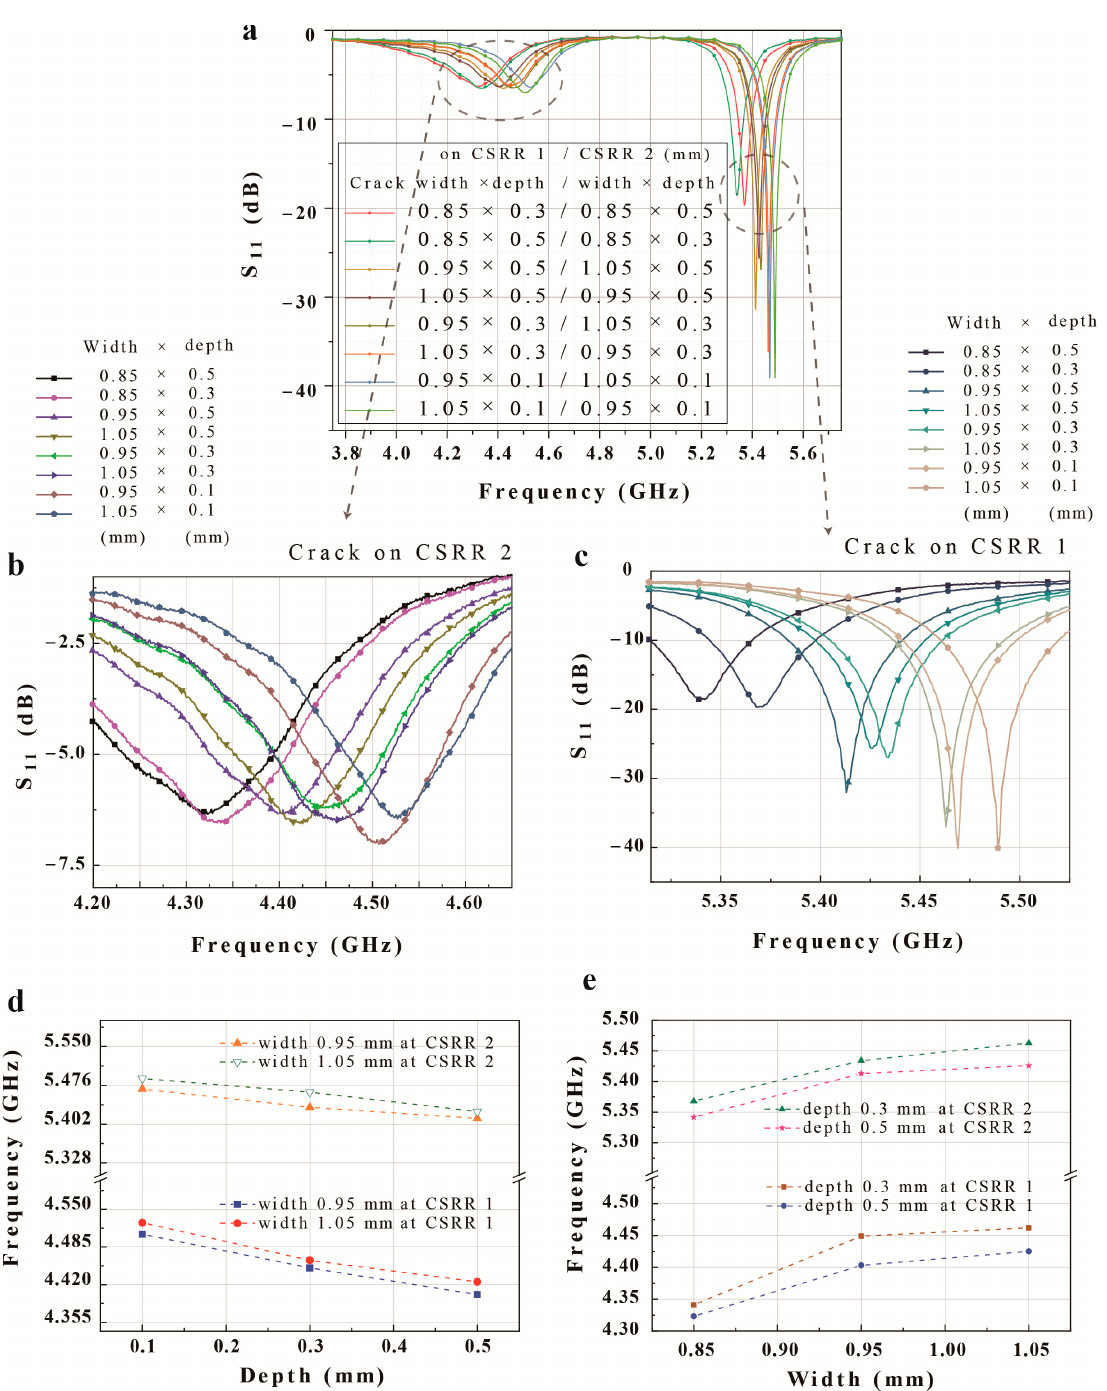
Figure 9. Measured S-parameters for the proposed dual-crack sensor ( a ) with various slot widths and depths at ( b ) CSRR 2 and ( c ) CSRR 1. Measured relationship between the frequency and various crack sizes: ( d ) depth and ( e ) width. Table 3. Proposed sensor performance for each CSRR.